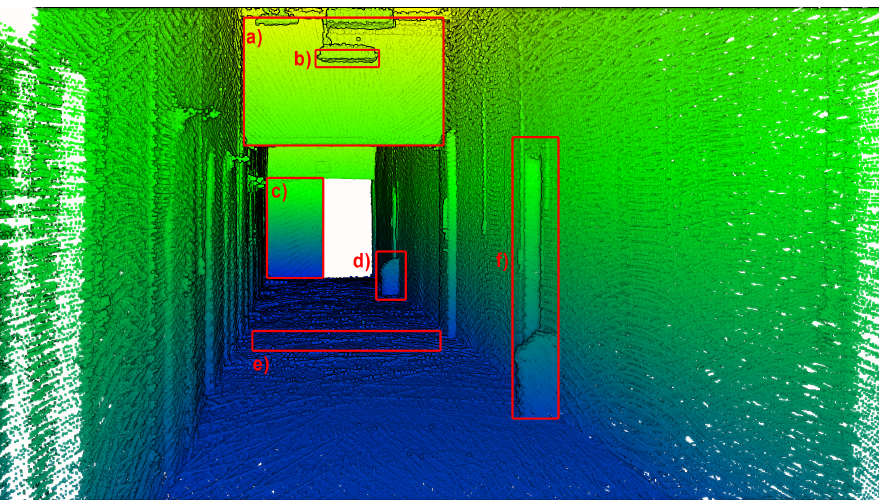
Figure 17. Objects selected for point cloud quality